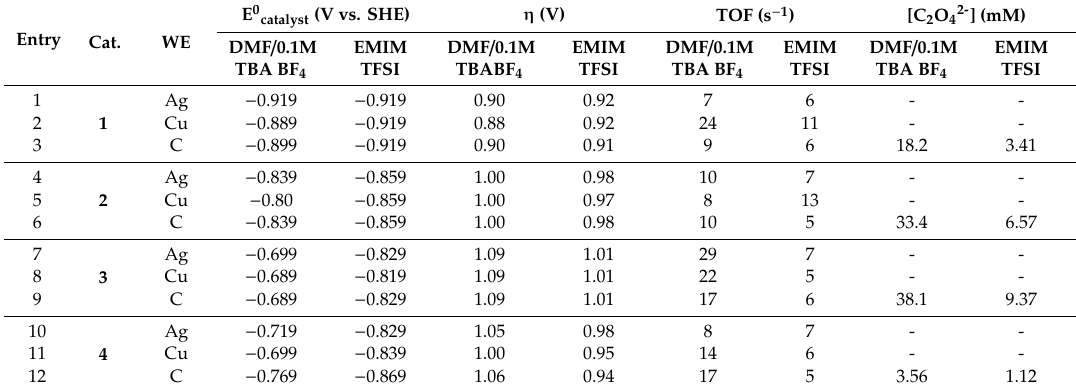
Table 2. Catalytic parameters in homogeneous catalysis of CO 2.